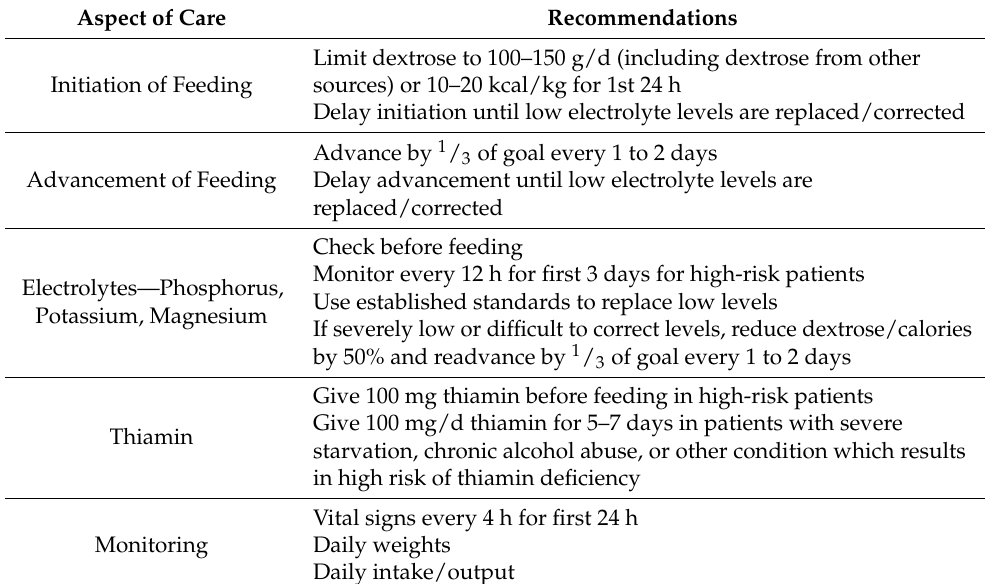
Table 1. Cont . Criterion Moderate Risk (2 Criteria) Severe Risk (1 Criterion) Moderately/significantly low levels OR Minimally low levels OR Minimally low/normal levels with Pre-feeding Potassium, normal current levels with recent recent low levels necessitating Phosphorus, Magnesium low levels necessitating minimal significant or multiple-dose or single-dose supplementation supplementation Subcutaneous Fat Moderate loss Severe loss Muscle Mass Mild/moderate loss Severe loss High Risk Comorbidities * Moderate disease severity Severe disease severity